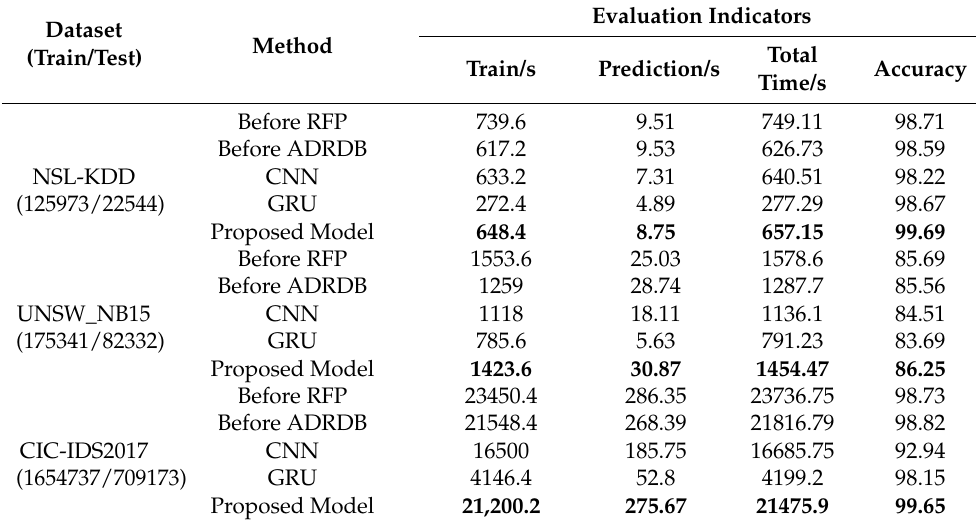
Table 12. Comparison of run-time